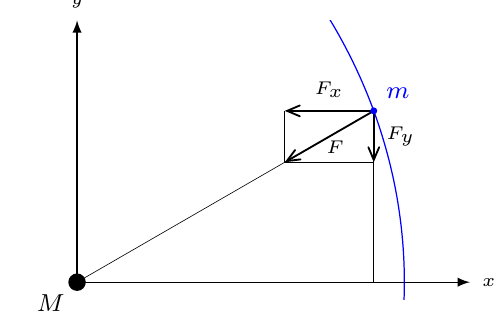
Fig. 106.— Planet with mass m orbiting in the xy plane under the gravitational influence of a central mass M in the